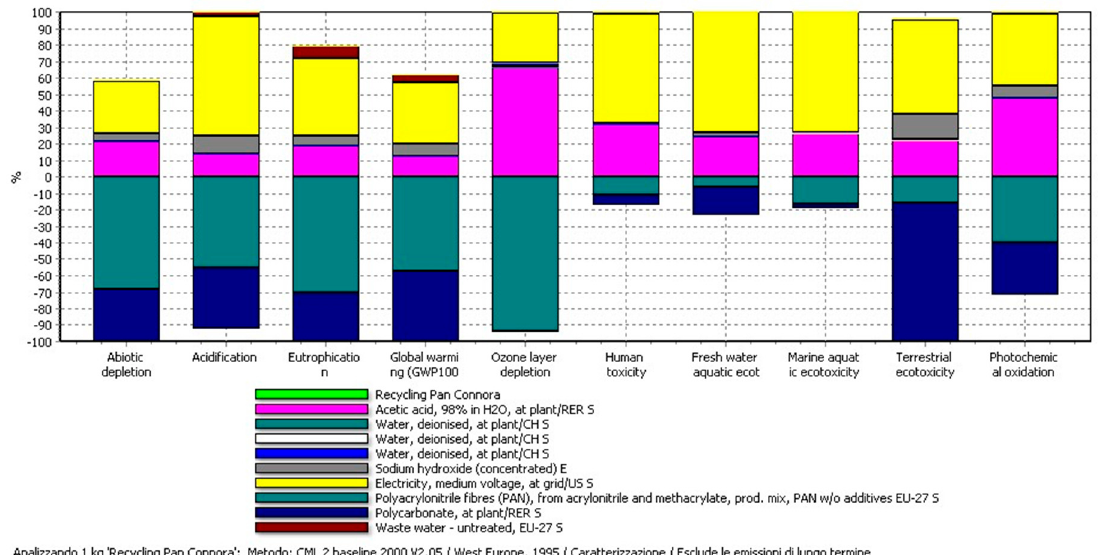
Figure 3. Network of the Connora recycling process according to the inventory data of Table 4. Percentage of GWPs are reported for each step according to the CML 2000 method.